Question: According to the figure, is the described quantity increasing or decreasing?
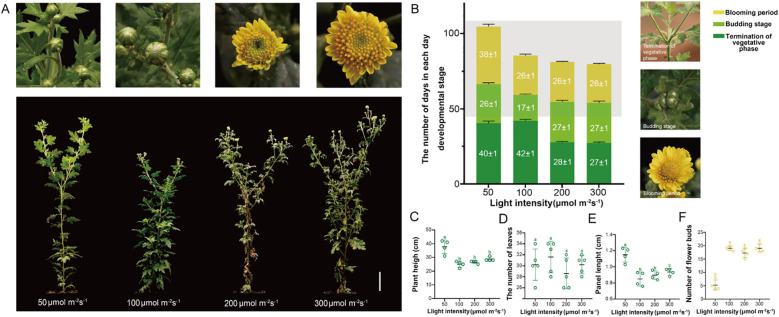
Answer: increasing